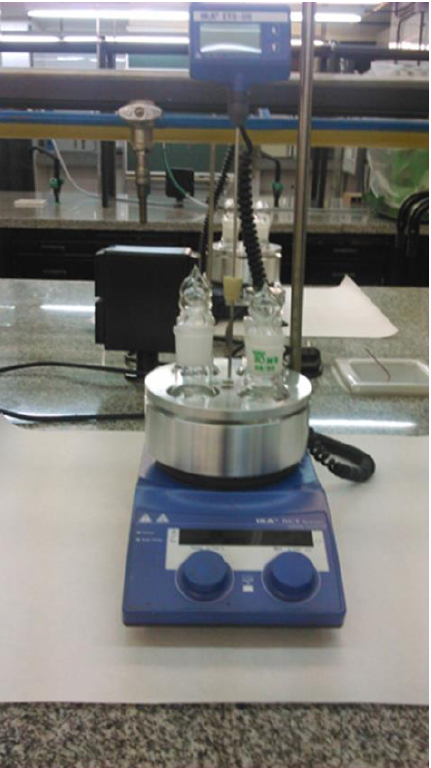
Figure 9. Experimental set-up showing the 50 mL round-bottomed flasks placed in the aluminum gasket inserted in a magnetic stirrer provided with a PID temperature control.